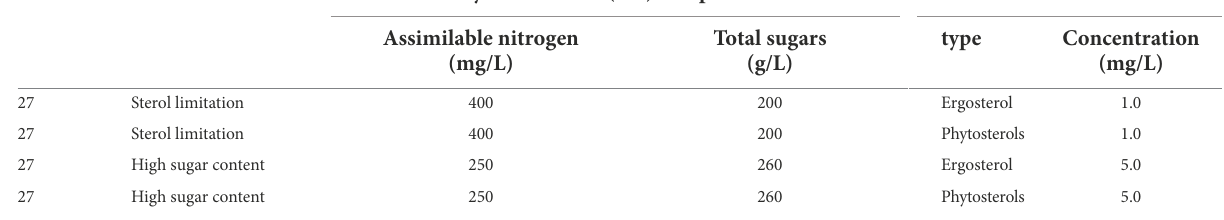
TABLE 1 Experimental designs: number of strains tested, synthetic must (SM) composition with assimilable nitrogen and total sugars and sterol type and concentration. Strains Condition Synthetic must (SM)